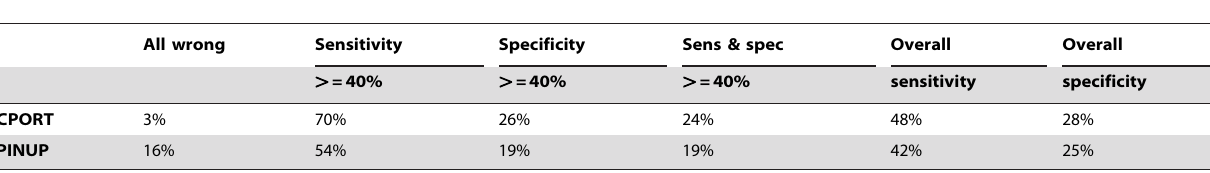
Table 2. Comparison between CPORT and PINUP on the benchmark